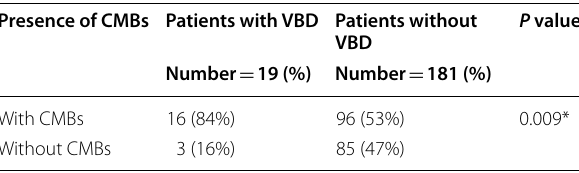
Table 4 Vertebrobasilar dolichoectasia and cerebral microbleeds incidence